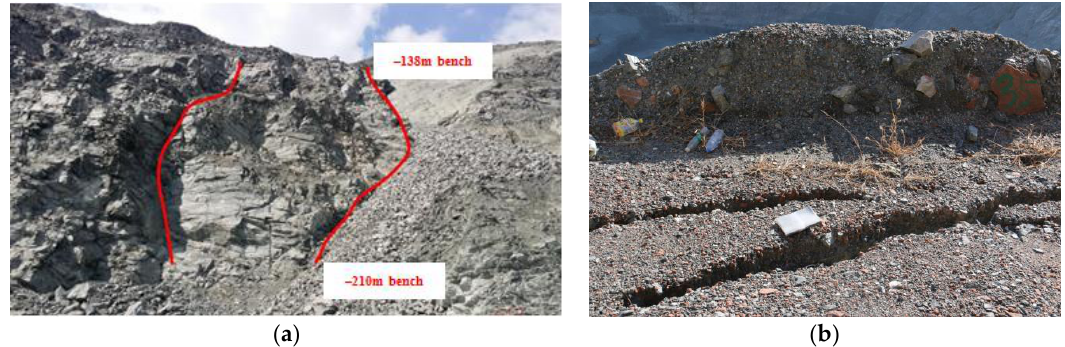
Figure 4. Photograph of the landslide on 27 May 2018: ( a ) left and right borders; ( b ) crack on the top border at −138 m bench.